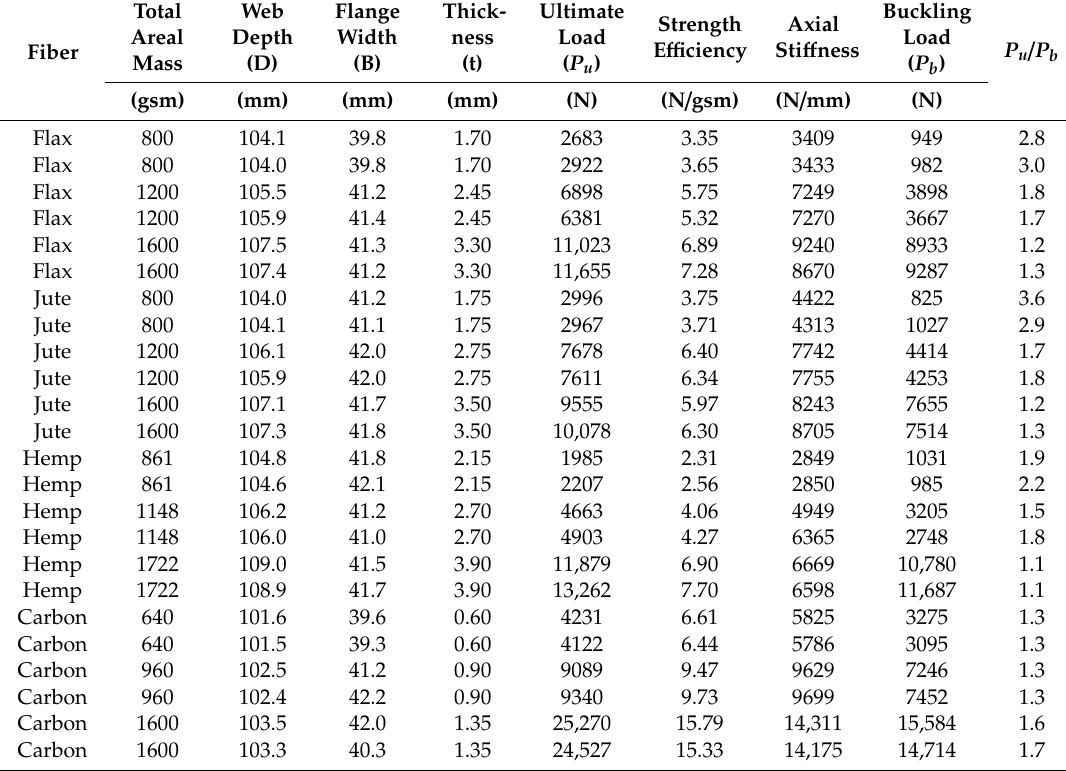
Table 1. Composite channel dimensions and test